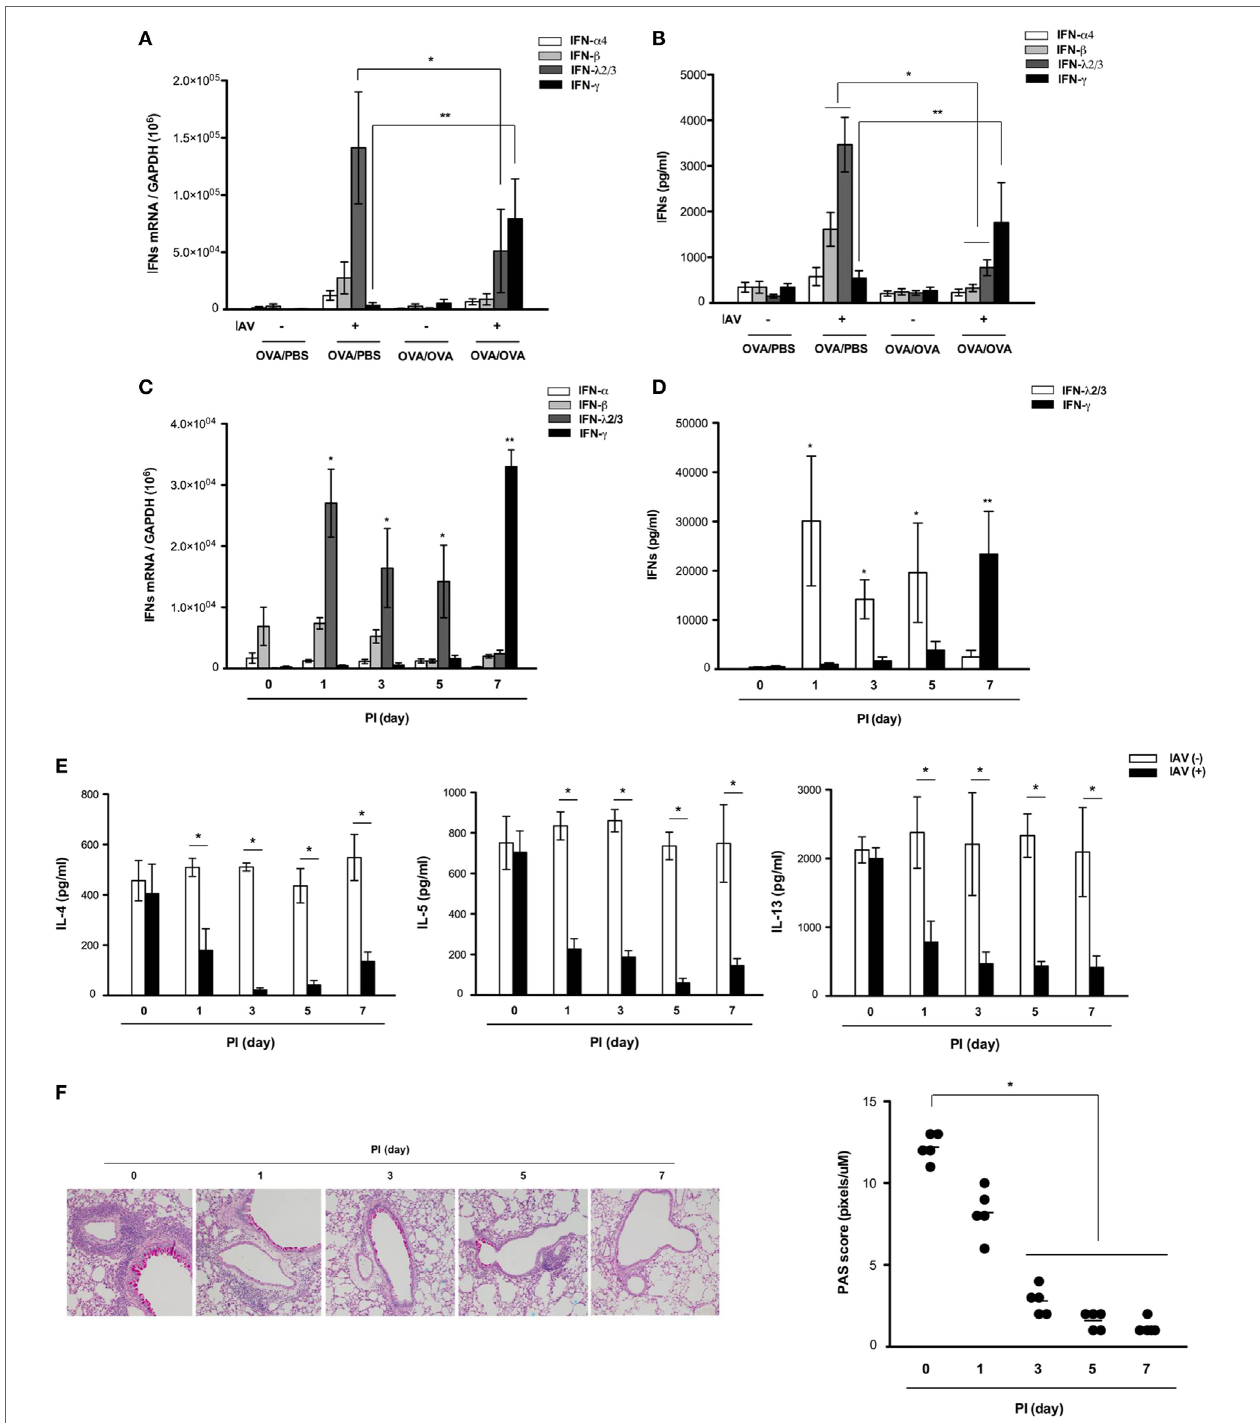
FigUre 3 | Expression and secretion of various interferons (IFNs) after influenza A virus (IAV) infection of non-asthmatic and asthmatic mice. Non-asthmatic ( N = 5) and asthmatic mice ( N = 5) were infected with 213 pfu IAV WS/33 (H1N1). The mRNA levels in the lung (a) and levels of secreted IFN- α , IFN- β , IFN- λ 2/3 , and IFN- γ in bronchoalveolar lavage (BAL) fluid (B) were determined by real-time polymerase chain reaction (PCR) and enzyme-linked immunosorbent assay, respectively, at 7 days after infection. The mRNA levels and levels of secreted IFN- α , IFN- β , IFN- λ 2/3 , and IFN- γ in the lung (c) and BAL fluid (D) were determined in IAV-infected asthmatic mice until 7 dpi. A multiplex assay was performed to quantify the levels of secreted Th2 cytokines in the BAL fluid of IAV-infected asthmatic mice until 7 dpi (e) . Histological assessment was performed using periodic acid Schiff (PAS)-stained lung sections of asthmatic mice ( N = 5) (F) harvested at 0 ( N = 5), 1 ( N = 5), 3 ( N = 5), 5 ( N = 5), and 7 ( N = 5) dpi. Micrographs shown are representative of five mice. PCR, plaque assay, and multiplex assay results are presented as mean ± SD from five independent experiments ( *,** p < 0.05 compared with the levels in non-asthmatic and asthmatic mice at 7 dpi, Figures 2B–D *IFN- λ 2/3 , **IFN- γ ).